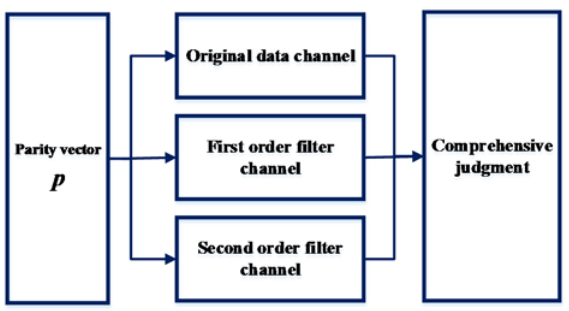
Figure 4. The fault detection method based on the three ‐ channel filter.